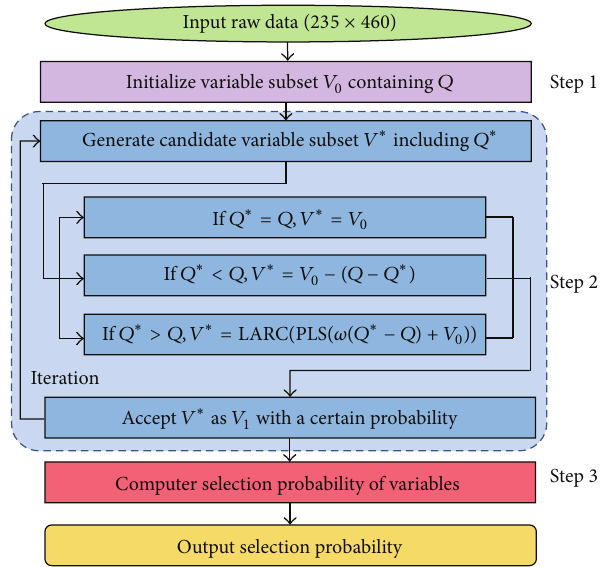
Figure 3: The flowchart of the random frog algorithm. Step 1: a variable subset 𝑉 0 containing 𝑄 variables is initialized randomly; Step 2: candidate variable subset 𝑉 ∗ including 𝑄 ∗ variables is generated according to the normal distribution norm (𝑄, 𝜃𝑄) ; Step 3: compute a selection probability of each